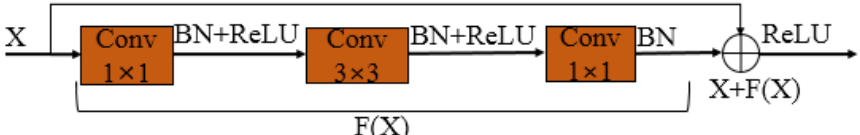
Figure 5. Residual learning module (Res). Conv, BN, and ReLU denote convolution, batch normalization, and rectified linear unit, respectively.